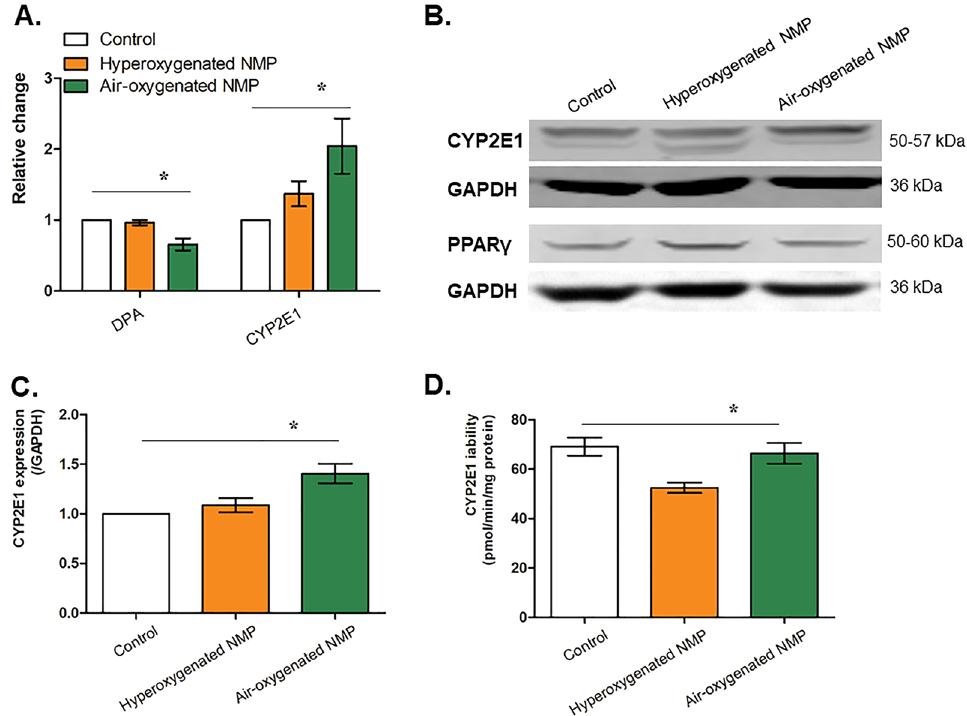
Figure 3. Expression of DPA, PPARγ and CYP2E1 in livers from donation after cardiac death using normothermic machine perfusion (NMP) (*denotes significant differences among control, hyperoxygenated NMP and air-oxygenated NMP, P < 0.05, n = 6). ( A ) Relative expression of DPA by metabolomics and CYP2E1 by proteomics; ( B ) Expressions of PPARγ and CYP2E1 by WB; ( C ) Semi-quantification of CYP2E1 by WB. ( D ) CYP2E1 activity quantified using the fluorescent